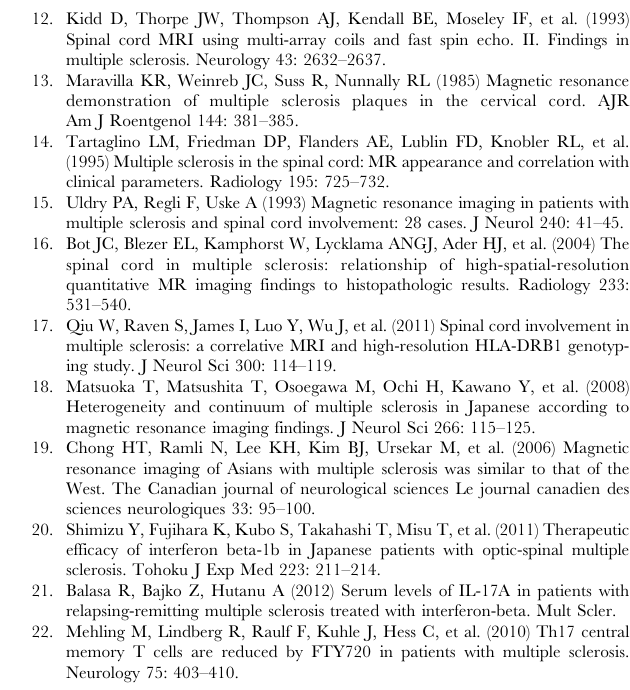
Table S1 Demographic statistics of the participants with a poor response to